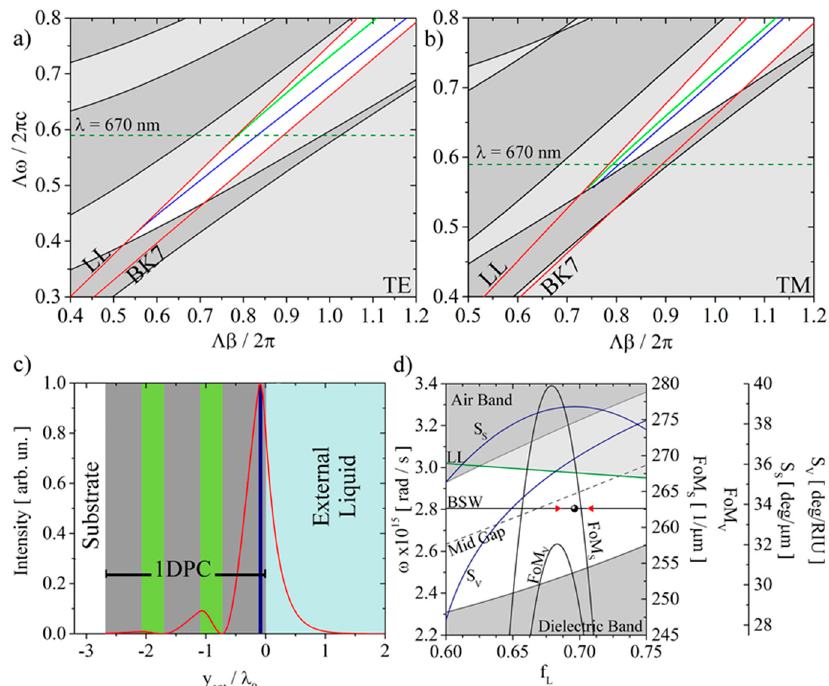
Figure 1. ( a ) TE and ( b ) TM photonic band structures for the silica and tantala 1DPC. ( c ) Electric field intensity (red line) into the 1DPC structure when a TE polarized BSW is excited. In gray are the silica layers, in green the tantala layers and in dark blue is the titania top layer. ( d ) TE band gap position as a function of the fill factor of the 1DPC periodic unit.